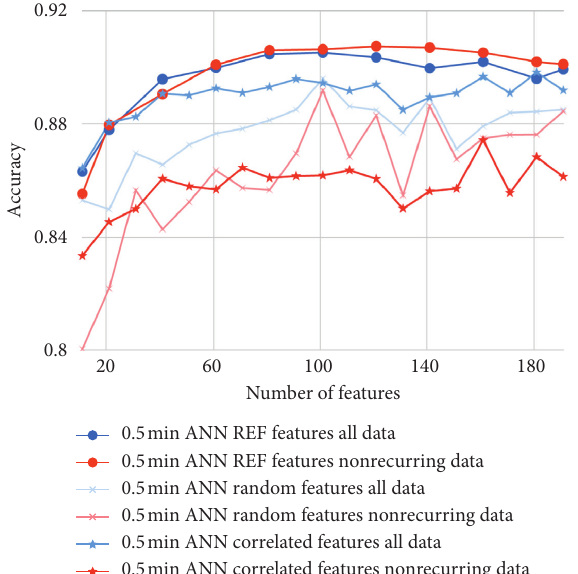
Figure 12: Performance comparison of RFE, correlation-based and random-selection approaches for selecting important attributes; results correspond to an ANN model for the 30sec input data aggregation